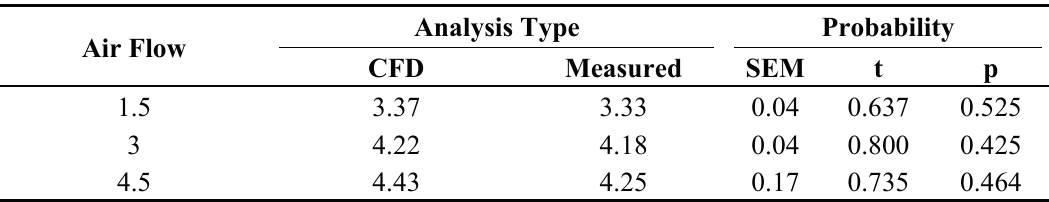
Table 8. Air velocity values of air flows generated by fans. The Student t test was used to compare the